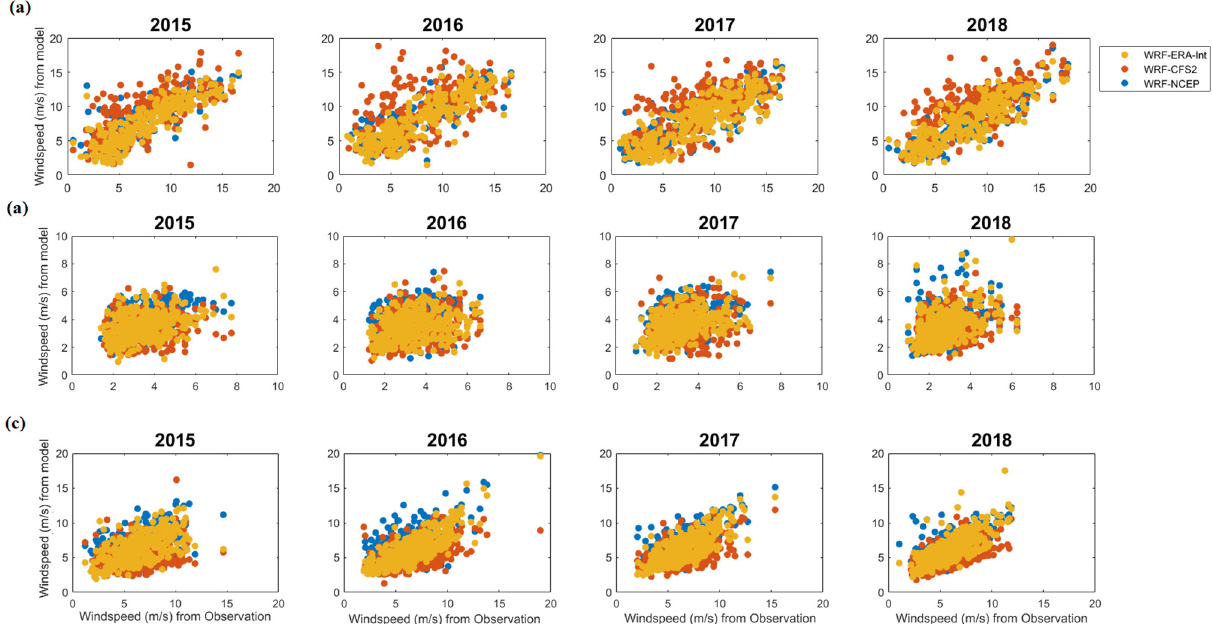
Figure A2. Daily average wind speed in m s − 1 from the models and observations at the offshore locations ( a ) Quanzhou, ( b ) Shanwei, and ( c ) Nansan.